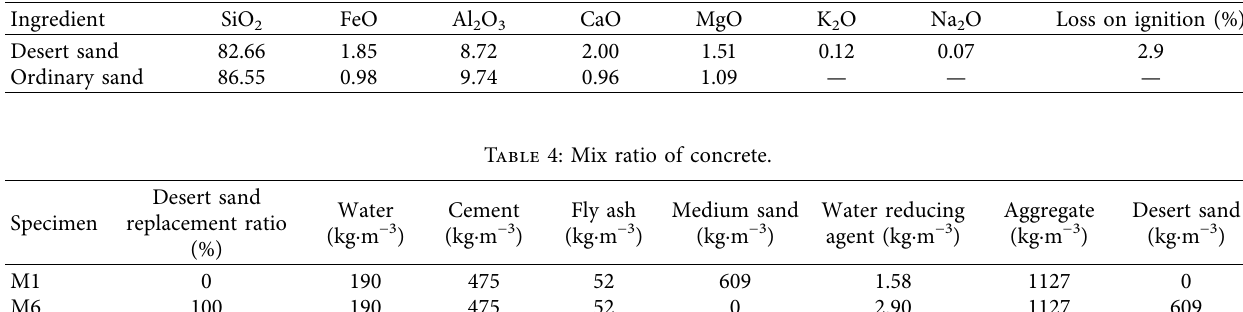
Table 3: Chemical composition of Mu Us desert sand.